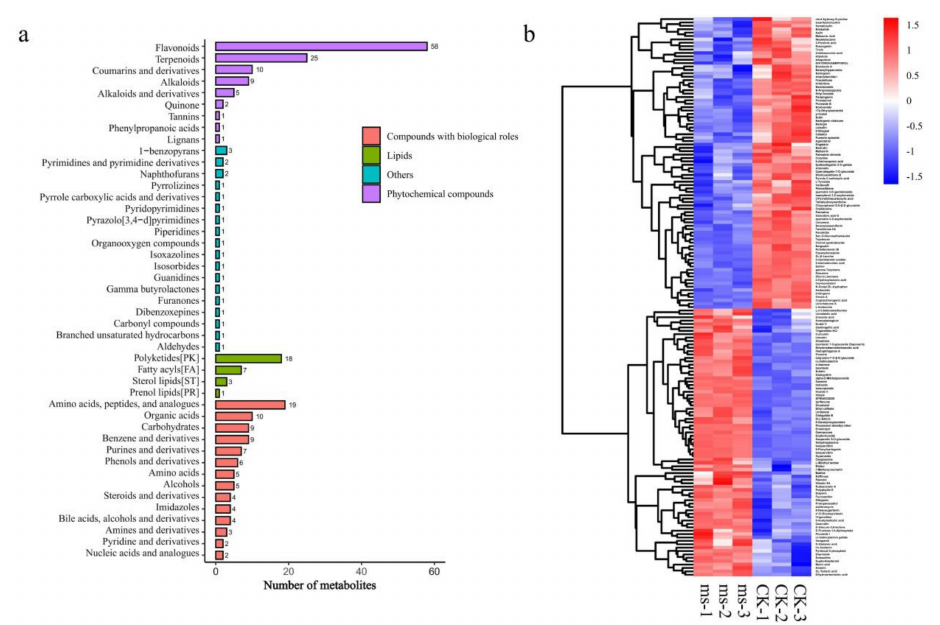
Figure 5. Metabolite profiling analyses. The statistical results of 252 metabolites’ classification that were identified in mungbean: ( a ) the ordinate represents the metabolic pathway, and the abscissa represents the number of metabolites; ( b ) heatmaps of the differential metabolites’ concentration in CK and ms .